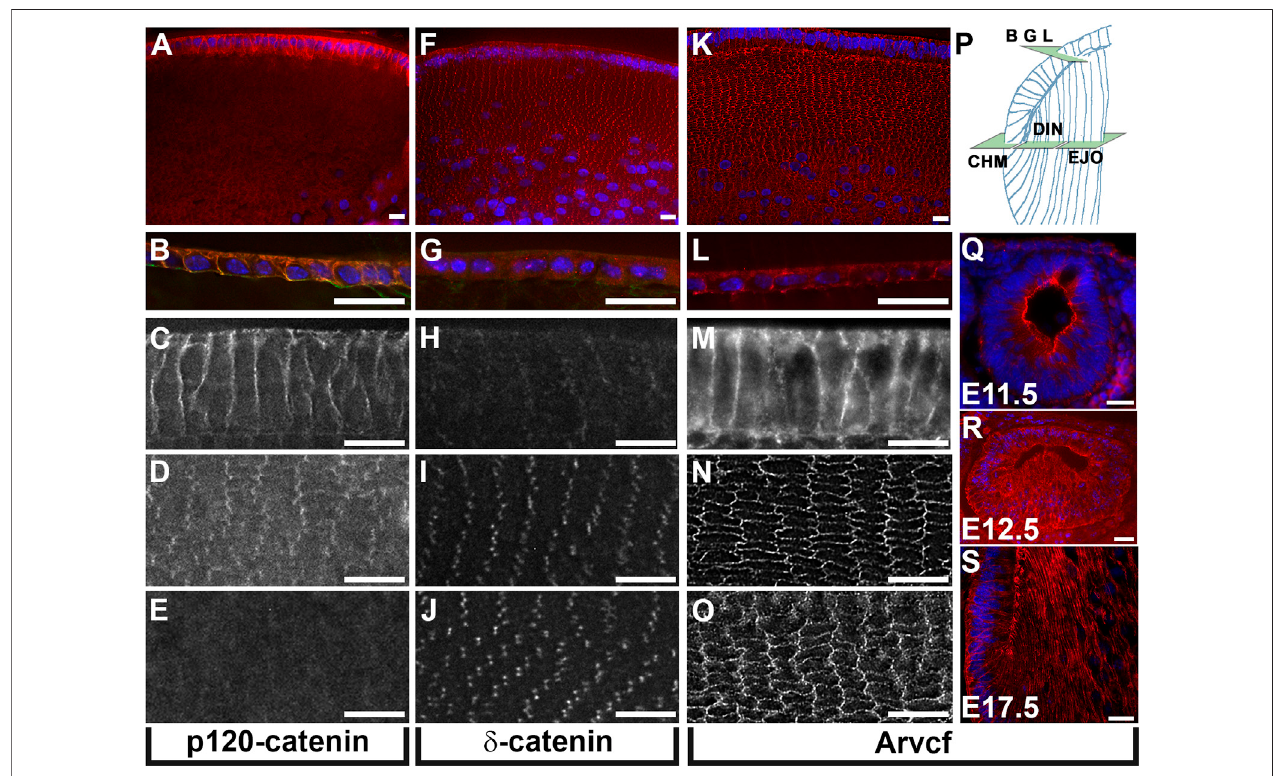
FIGURE1 | Lens expression ofp120-catenin subfamily proteins. (A – O) Immuno fl uorescent labeling of equatorially cryosectioned juvenile mouse lenses (P7)using antibodiesspeci fi cforp120-catenin (A – E) δ -catenin (F – J) ,andArvcf (K – O) . (P) Diagramofaportion ofthelensindicatingtheplaneofsection andapproximatelocation withinthelensfor (A – O) .Expressionwithinthelensepithelium (B,G,L) ,theoutermostelongatinglens fi bercellsnearthefulcrum (C,H,M) ,theoutermostcorticallens fi ber cells within 50 microns of the surface (D,I,N) , and lens fi ber cells 100 microns from the surface (E,J,O) is depicted. Note that p120-catenin and Arvcf but not δ - catenin are localized to the junctions of lens epithelial cells and that δ -catenin and Arvcf are much stronger than p120-catenin in lens fi ber cells. Arvcf is also localized strongly to bicellular lens fi ber cell junctions while δ -catenin appears restricted to lens fi ber cell tricellular junctions. (Q – S) Immuno fl uorescent labeling of transversely cryosectioned mouse embryos at the indicated ages immuno fl uorescently labeled for Arvcf (red). Blue signal for all panels represents Hoechst labeling of nuclei. A Plan- Apochromat ×40/1.3 Oil objective with wide- fi eld fl uorescent microscope was utilized. Scalebars = 25 microns.